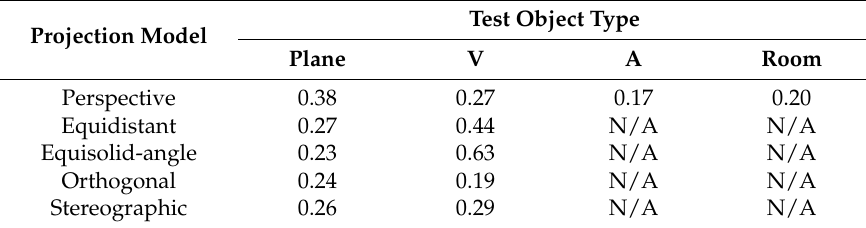
Table 10. RMSE of principal point coordinates (pixel).